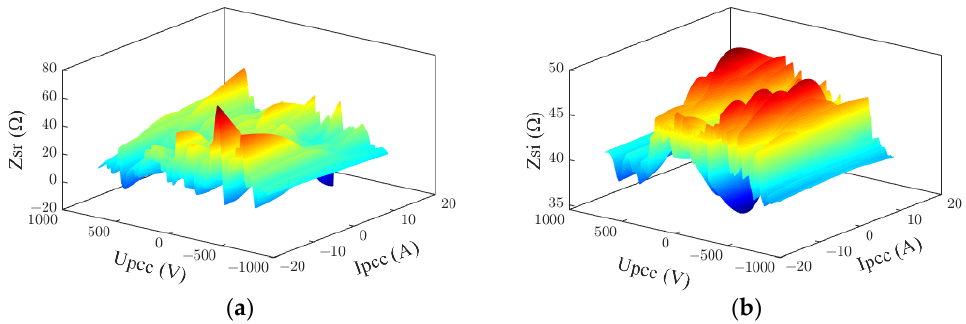
Figure 20. Results of method 4 in 3rd harmonic. ( a ) Result of real part; ( b ) Result of imaginary part. Table 7. Evaluation indexes of method 4 in 3rd harmonic. Table 6. Evaluation indexes of method 3 in 3rd harmonic.